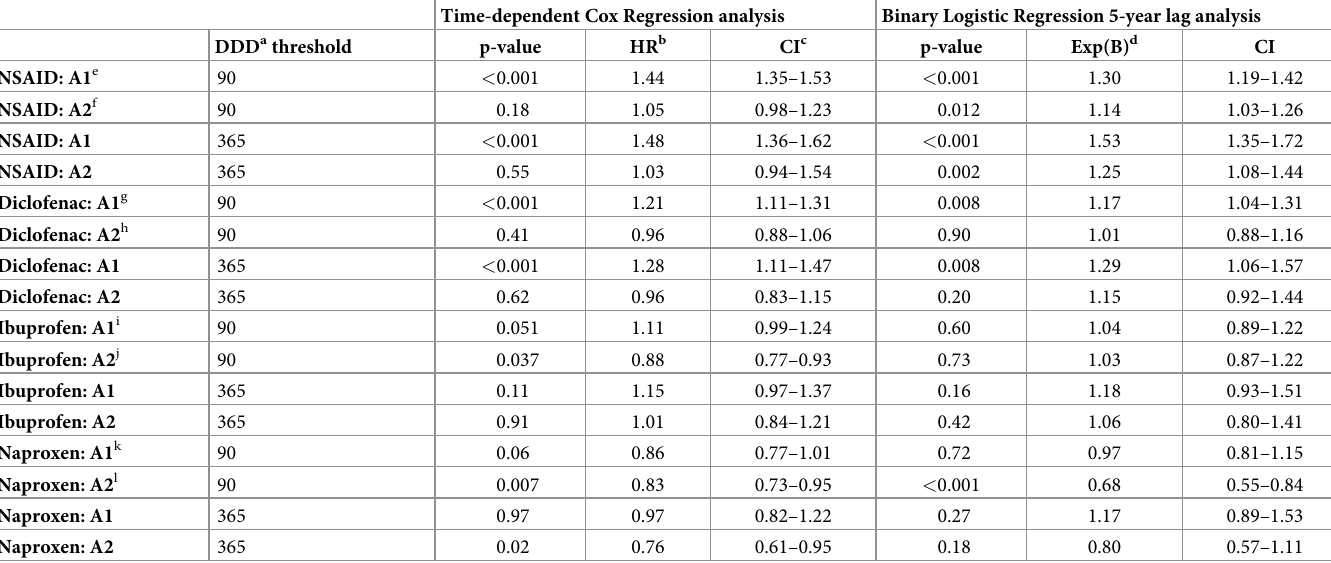
Table 4. Results from time-dependent Cox regression analysis and binary logistic regression